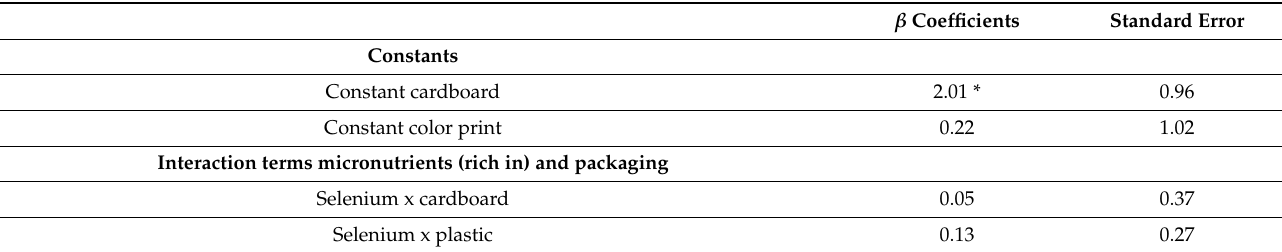
Table 6. Results of the multinomial conditional logit